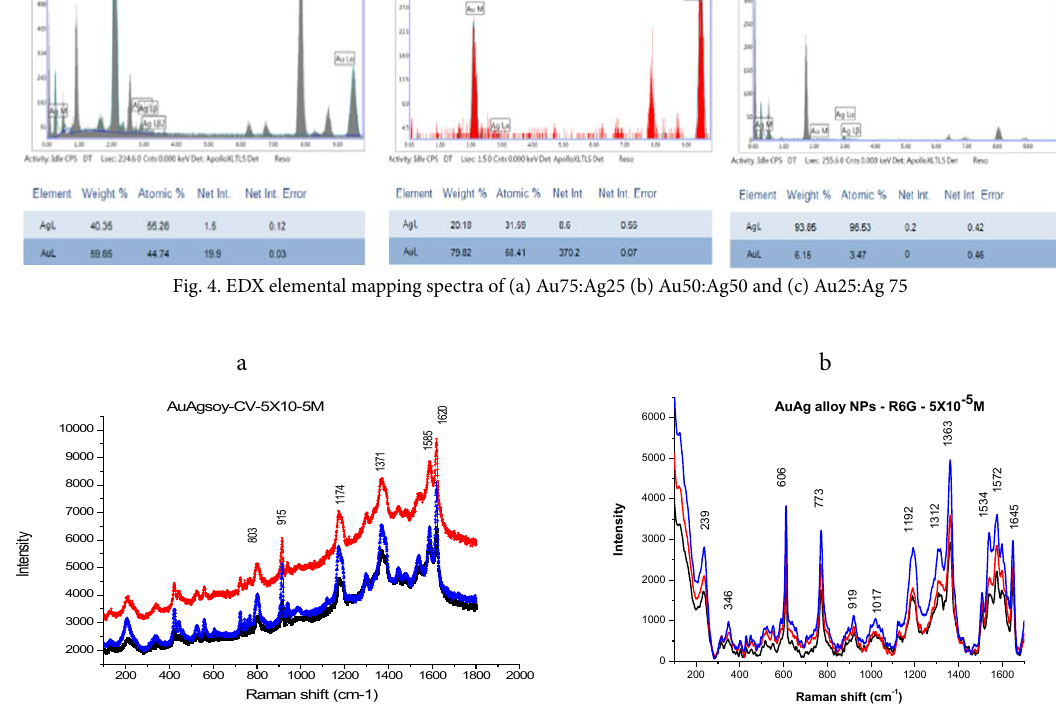
Figure 5(b) : The SERS spectra of 50 µM concentration R6G on eco-friendly Au- Ag alloy nanoparticles (Au50:Ag 50) on glass